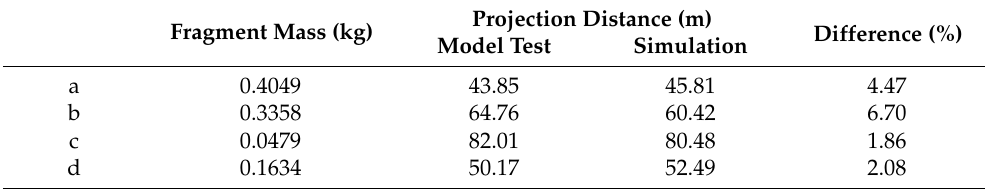
Figure 23. Concrete fragments and the size. ( a ) fragment a; ( b ) fragment b; ( c ) fragment c; ( d ) fragment d. Table 7. Comparison of actual projection distance and calculated